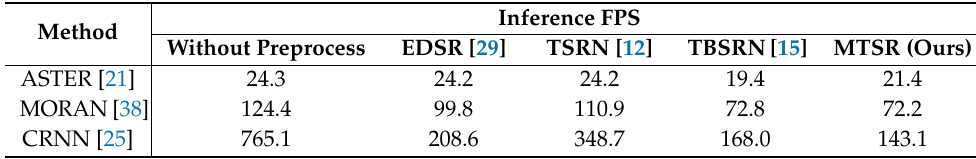
Table 6. Comparison of processing speed with and without SR as